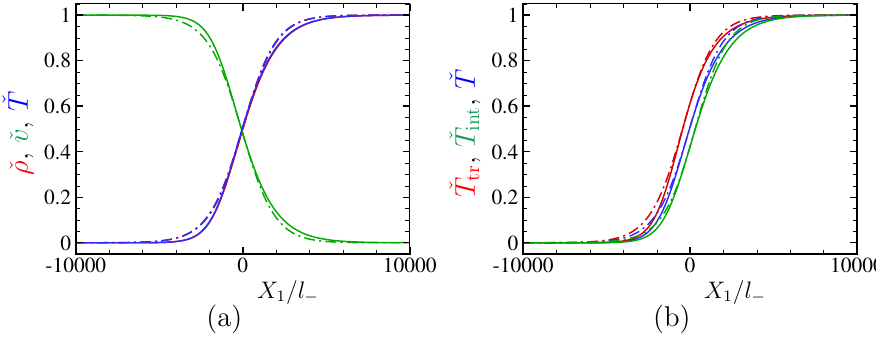
Figure 14. Profiles of ˇ ρ , ˇ v , ˇ T , ˇ T tr , and ˇ T int in the case of CH 4 gas at M − = 1.05. ( a ) ˇ ρ , ˇ v , and ˇ T ; ( b ) ˇ T tr , ˇ T ˇ T . See the caption of Figure int , and